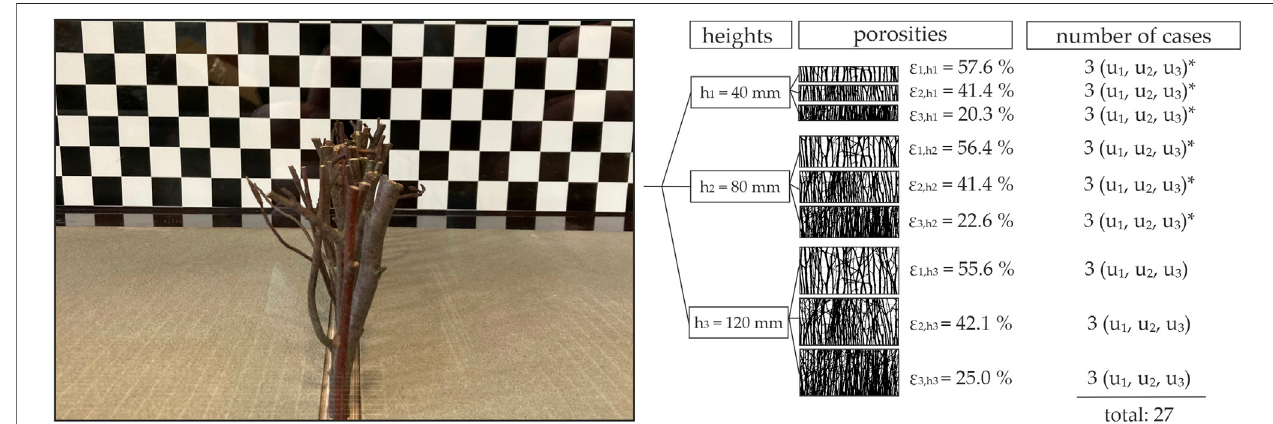
FIGURE 4 | Modeling nine different sand-trapping fences with changing fence heights and fence porosities and showing the number of cases investigated (*only wind pro fi les were measured).